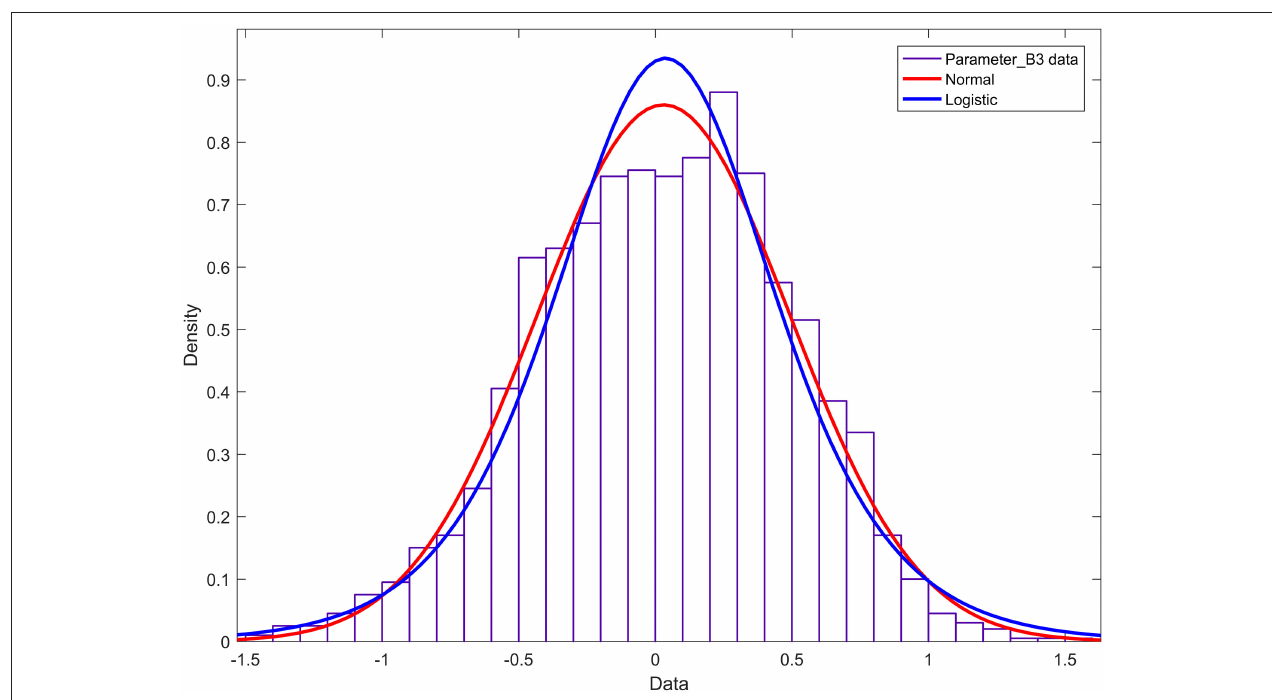
FIGURE 7 | Histogram and probability density function of parameter b3.